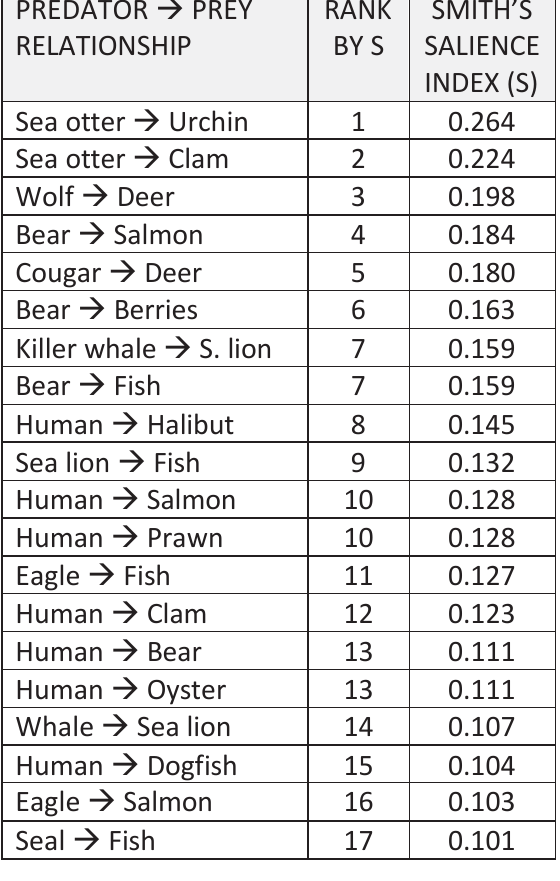
Most cognitively